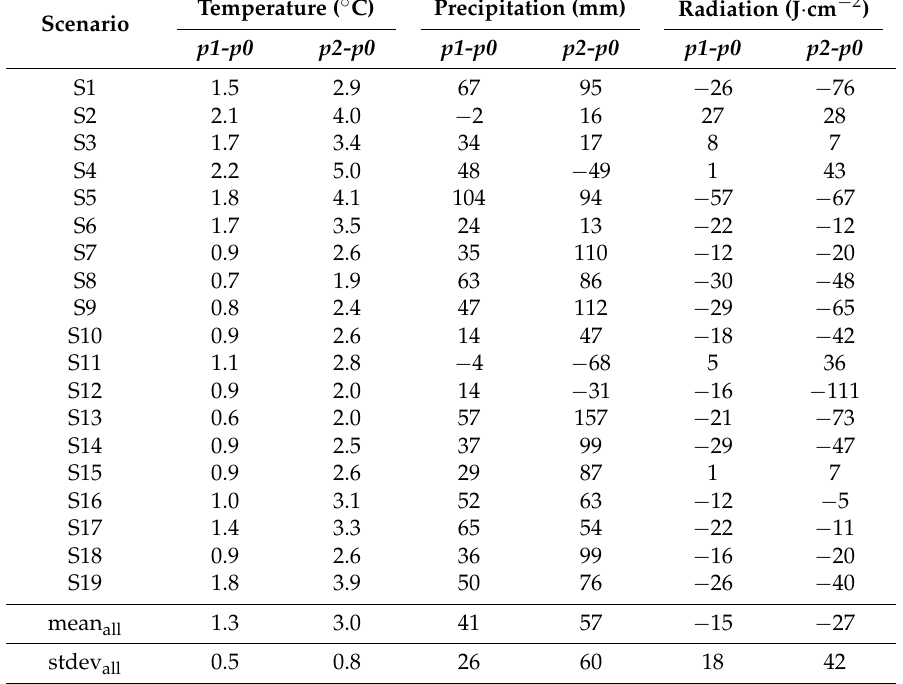
Table 8. Climate change signals for temperature, precipitation and radiation of 19 analyzed ENSEMBLES climate scenarios and on average for the two future periods 2021–2050 (p1) and 2071–2098 (p2) compared to the reference period 1971–2000 (p0) for the Elbe